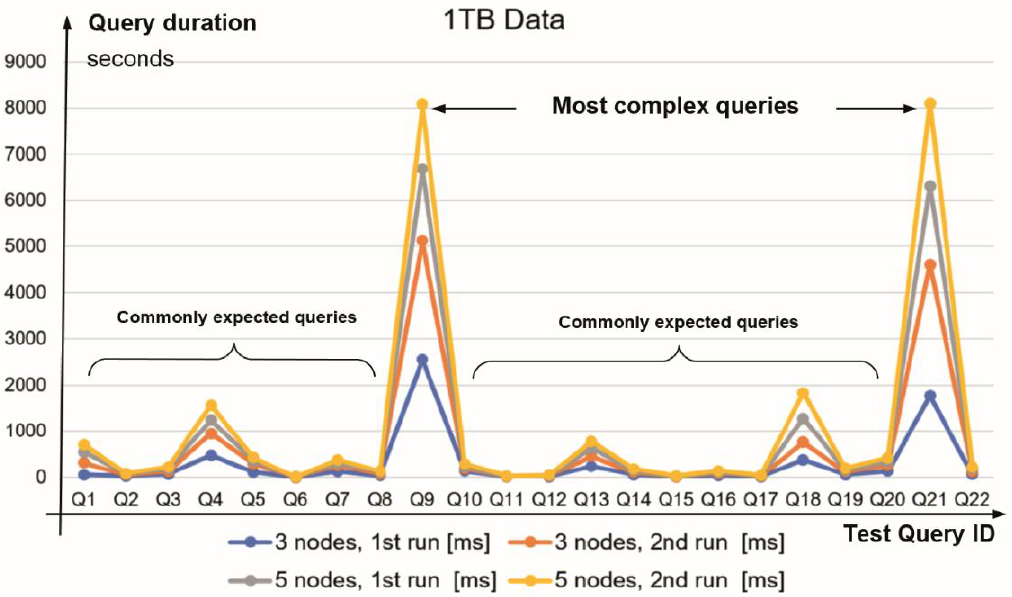
Table 2. Measured results compliant with TPC-H benchmarks for initial import of 1 TB and 3 TB test databases.